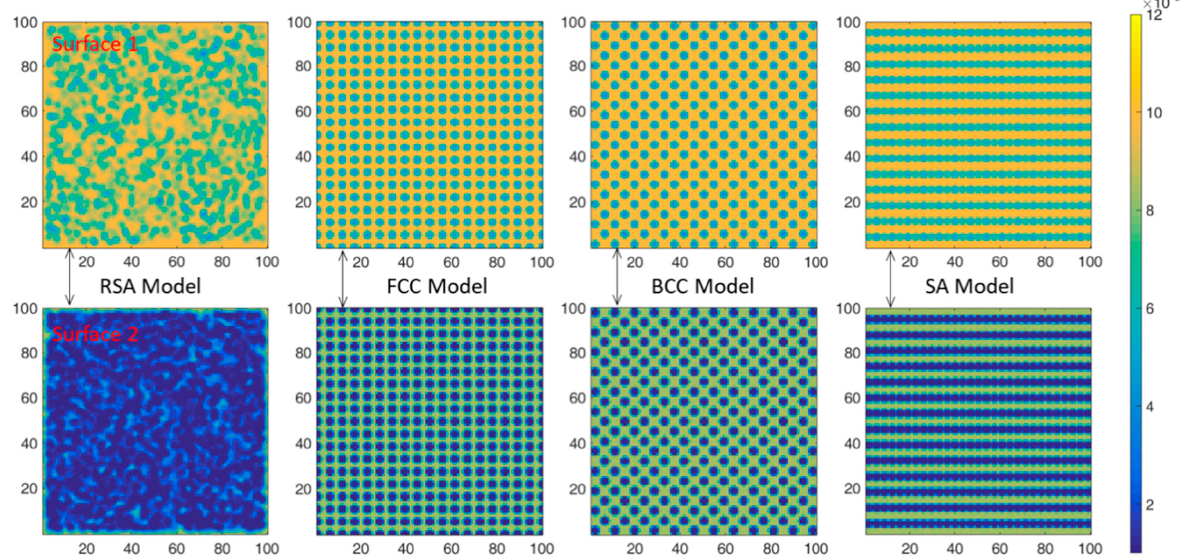
Figure 8. In the case of 0.0253 eV neutrons, the neutron flux distributions at surface 1 and surface 2 under different spatial arrangements.